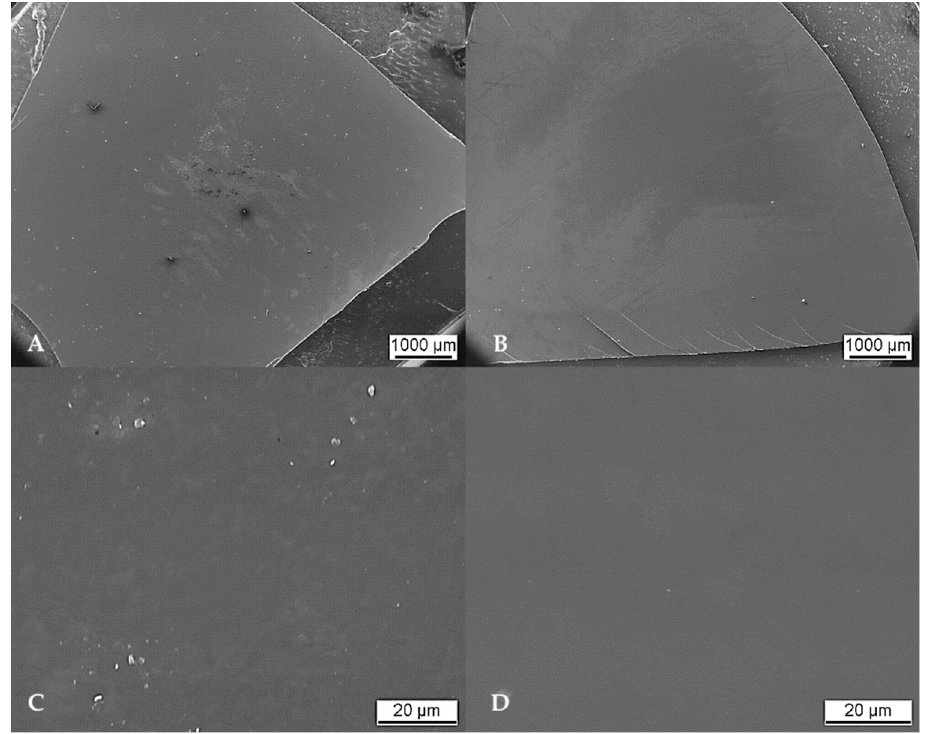
Figure 2. SEM images of SF10 membrane ( A , C ) and SF12 membrane ( B , D ) in low ( A , B ) and high magnification ( C , D ).